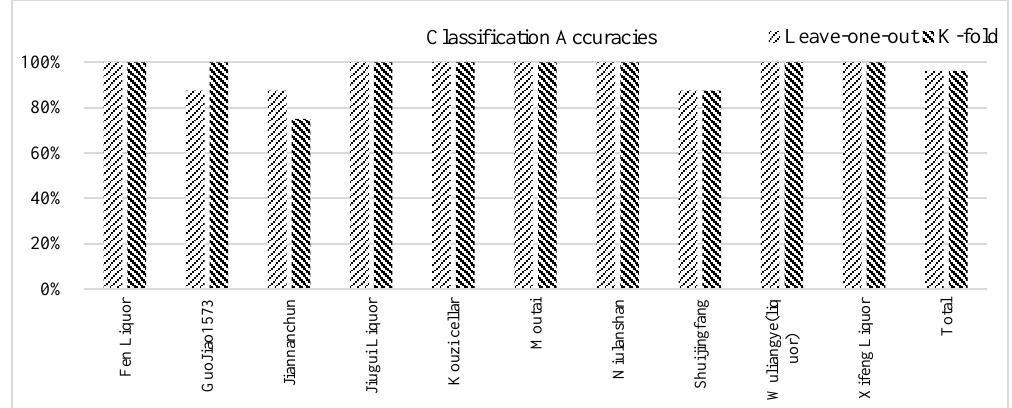
Figure 13. Classification accuracies of the ten brands of Chinese liquors by leave-one-out cross-validation and 5-fold cross-validation. Table 4. Classification results of Chinese liquor samples by leave-one-out cross-validationand 5-fold cross-validation.